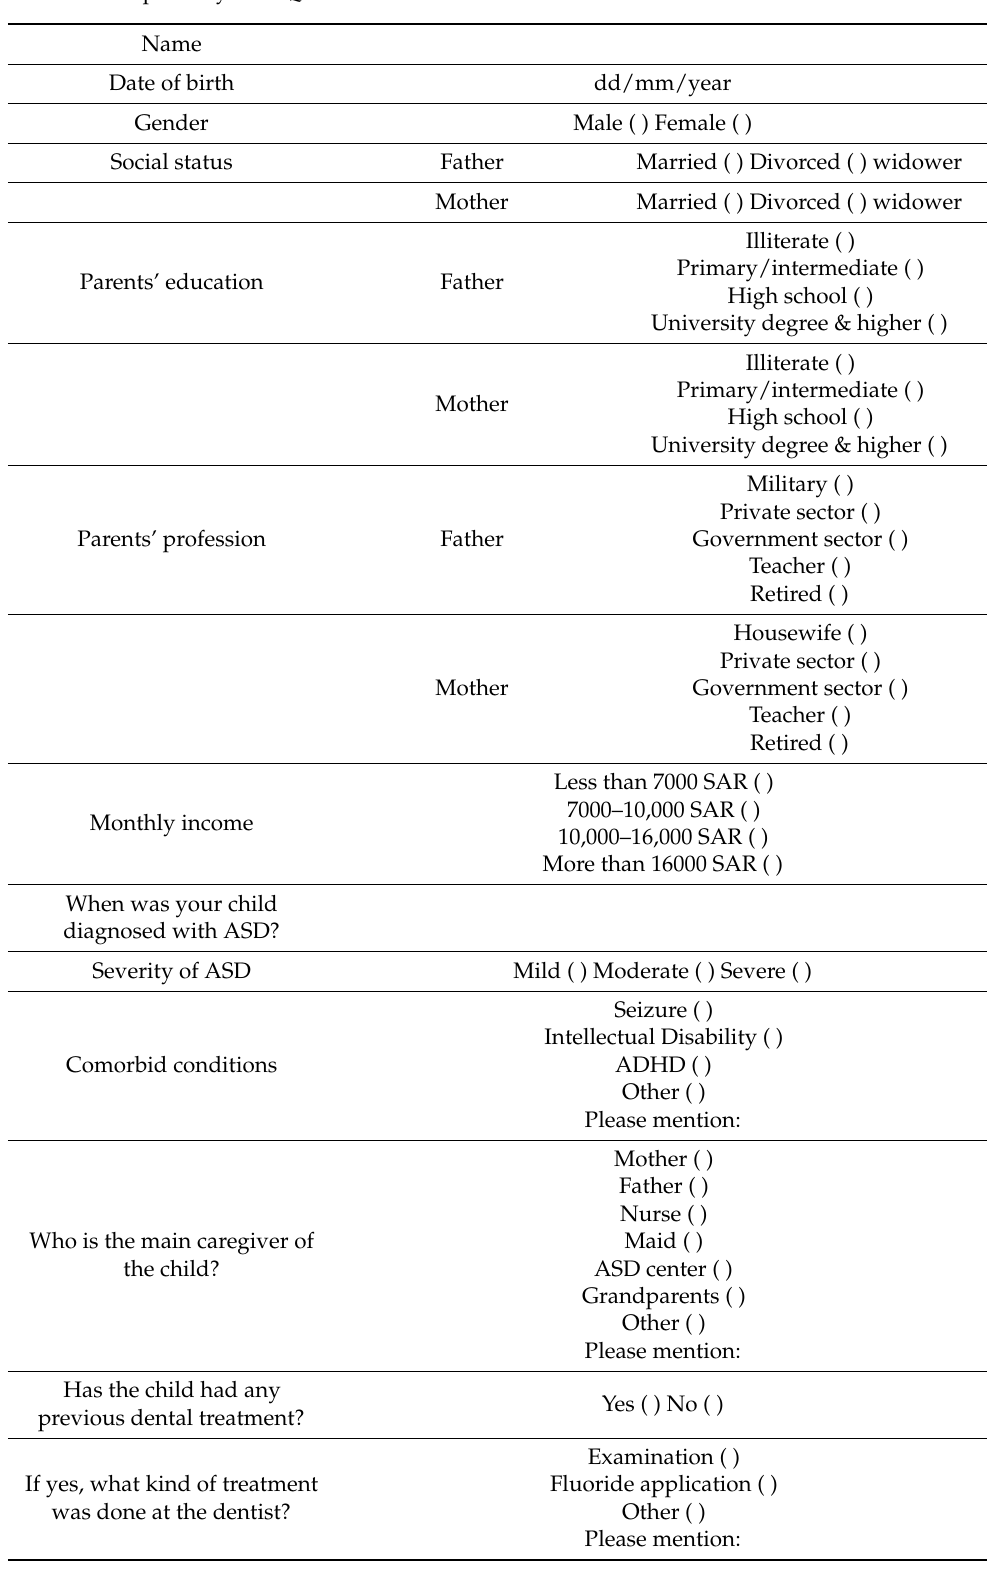
Table A1. Preparatory Visit